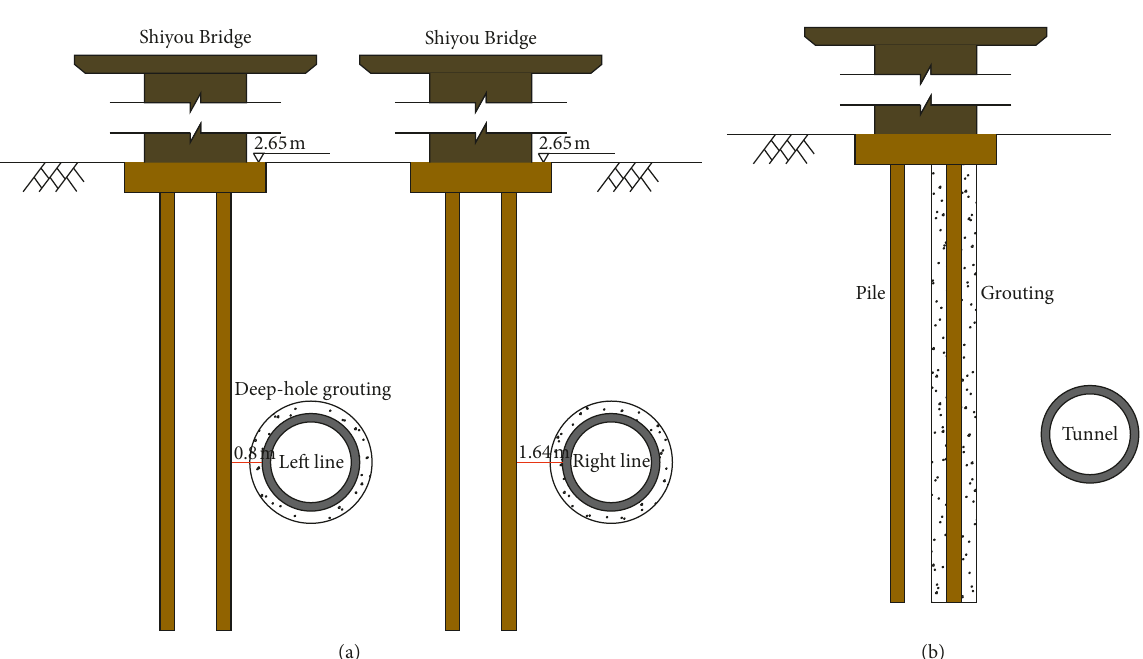
Figure 8: Grouting reinforcement scheme: (a) deep-hole grouting; (b) grouting for